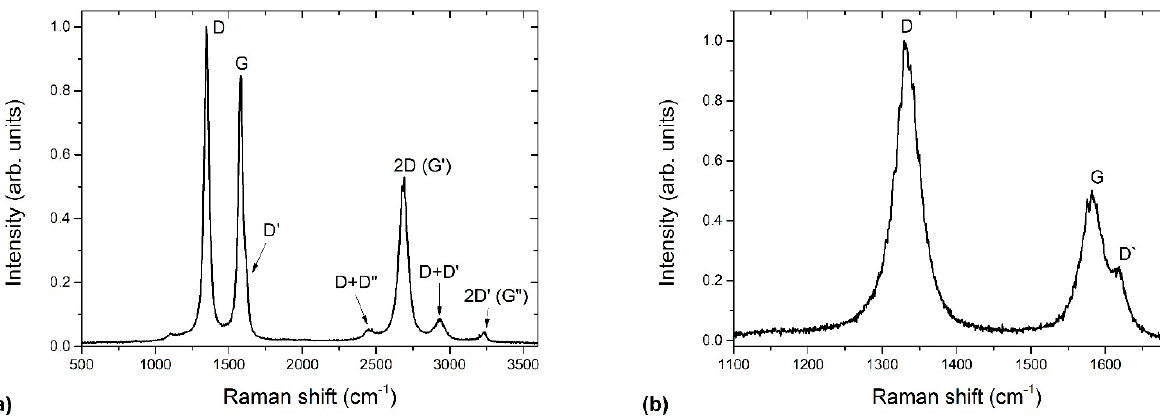
Figure 14. ( a ) Raman spectra of a reference undoped carbon nanomesh, ( b ) a detail showing a D’ band.